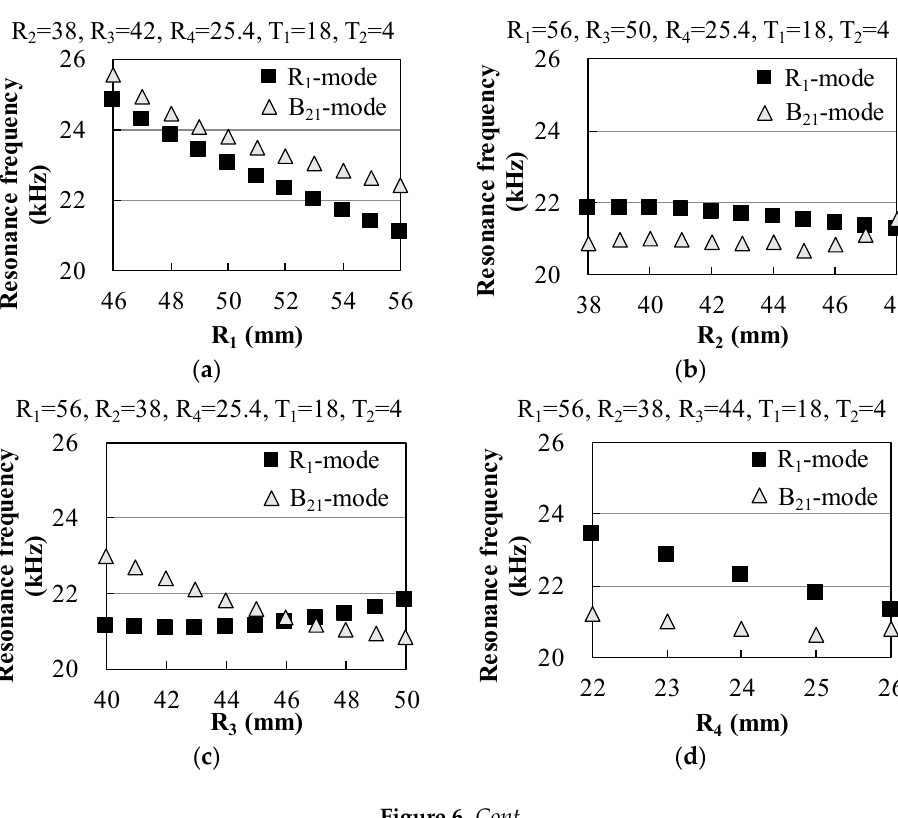
Figure 5. Dimensional parameters of the new stator.